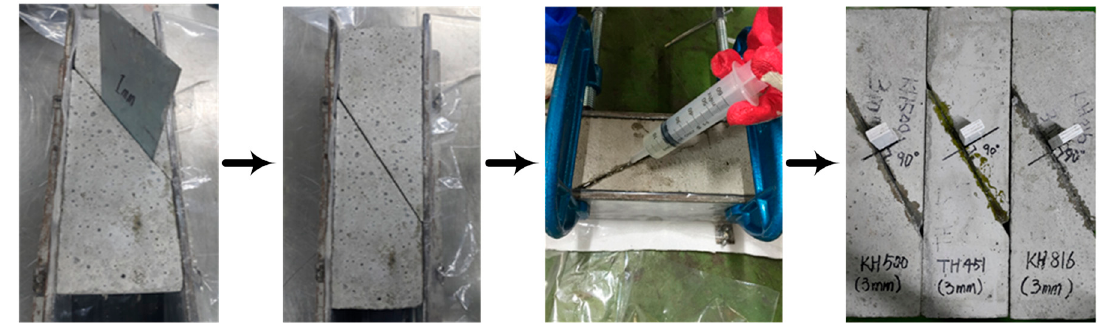
Figure 2. Concrete prism preparation with controlled adhesive layer.